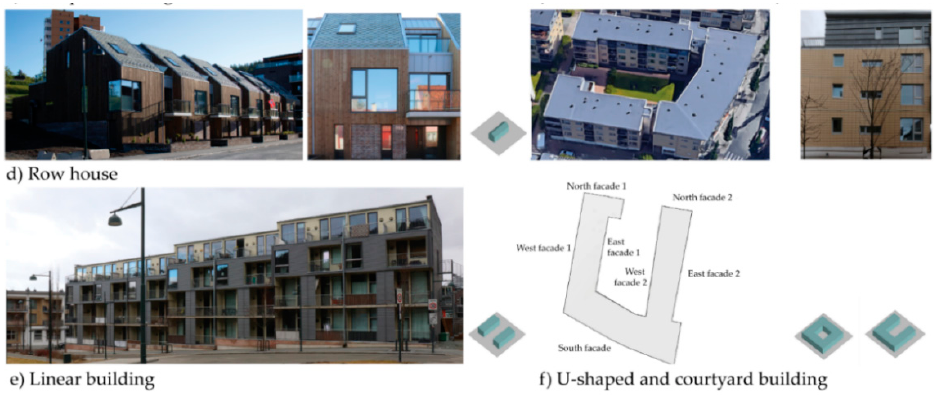
Figure 6. Examples of the most common types of building typologies in Trondheim. Table 7. Criteria for choosing buildings for reduction factor analysis.